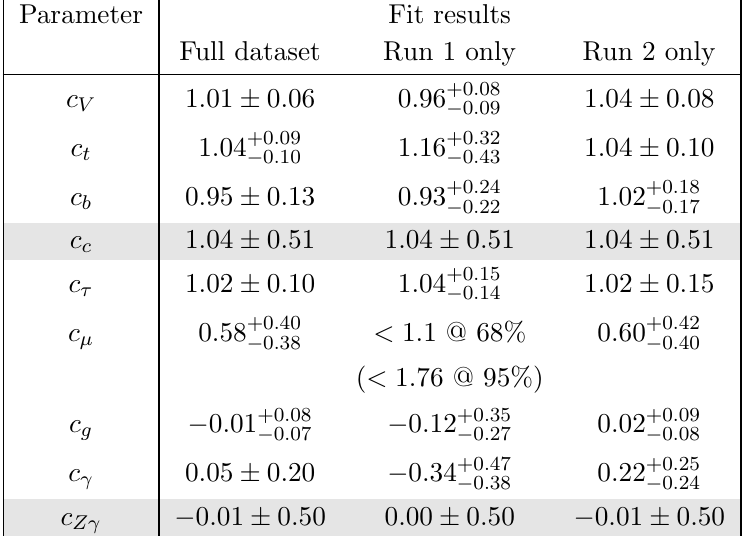
Table 2 . Results from the (cid:12)ts around the SM solution using the set of priors denoted as P EFT . These are (cid:13)at priors in the range c i = c SM (cid:6) 1 and c t + c g > 0 for all parameters except for c c and i c Z(cid:13) , which have Gaussian priors with (cid:27) = 0 : 5, see eq. (4.5). The results for c c and c Z(cid:13) (identi(cid:12)ed by shades of gray in the table) are fully prior dominated. For each parameter we quote the median and error | de(cid:12)ned from the boundaries of the 68% probability interval | computed from the corresponding 1D posterior